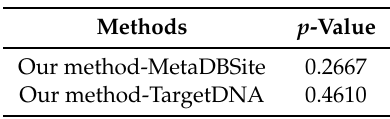
Table 7. The statistical significance of MCC between other methods (including MetaDBSite and TargetDNA) and our method.